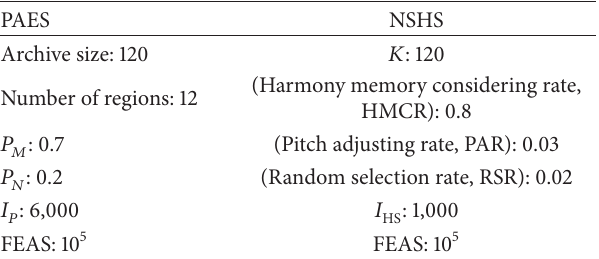
Table 6: Parameter setup of the PAES and